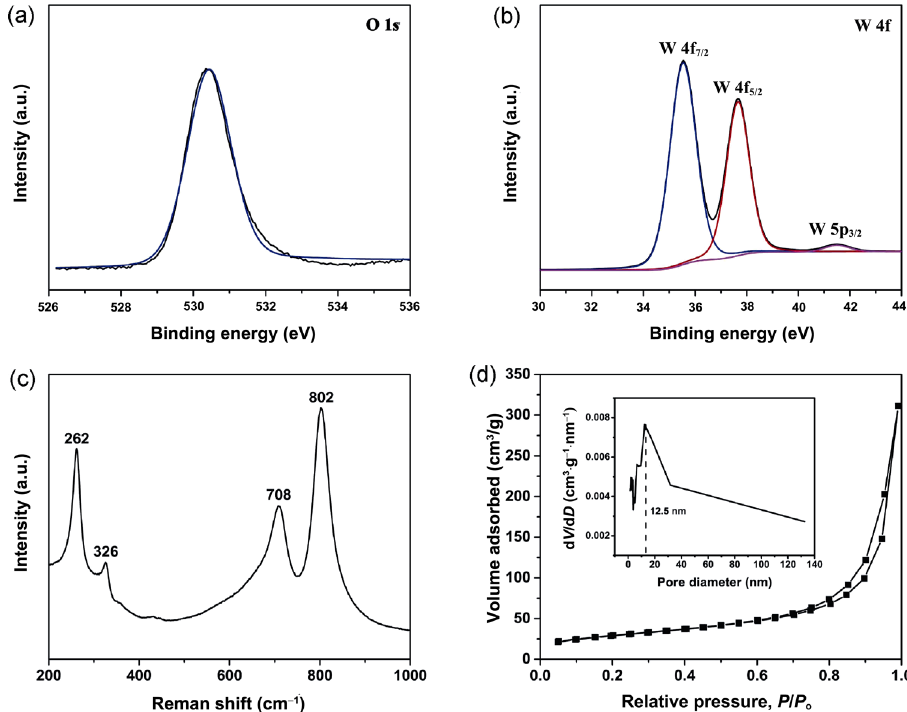
Fig. 5 (a) O 1s and (b) W 4f region XPS spectra of the WO 3 nanomesh; (c) Raman spectra of the WO 3 nanomesh; (d) nitrogen adsorption/desorption isotherm and the corresponding BJH pore size distribution plots (inset) of the WO 3